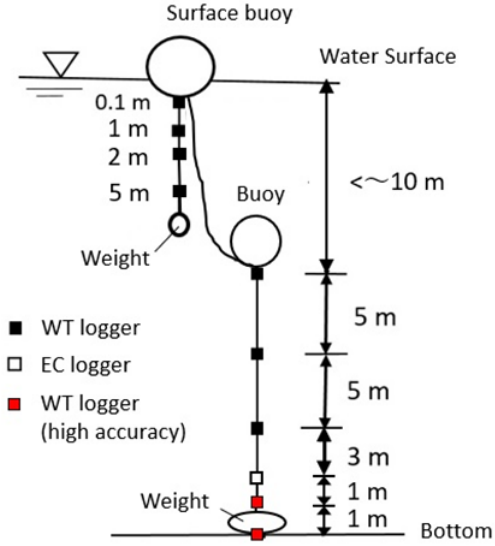
Figure 2. Mooring system for fixing ten loggers at site MD in 2021.